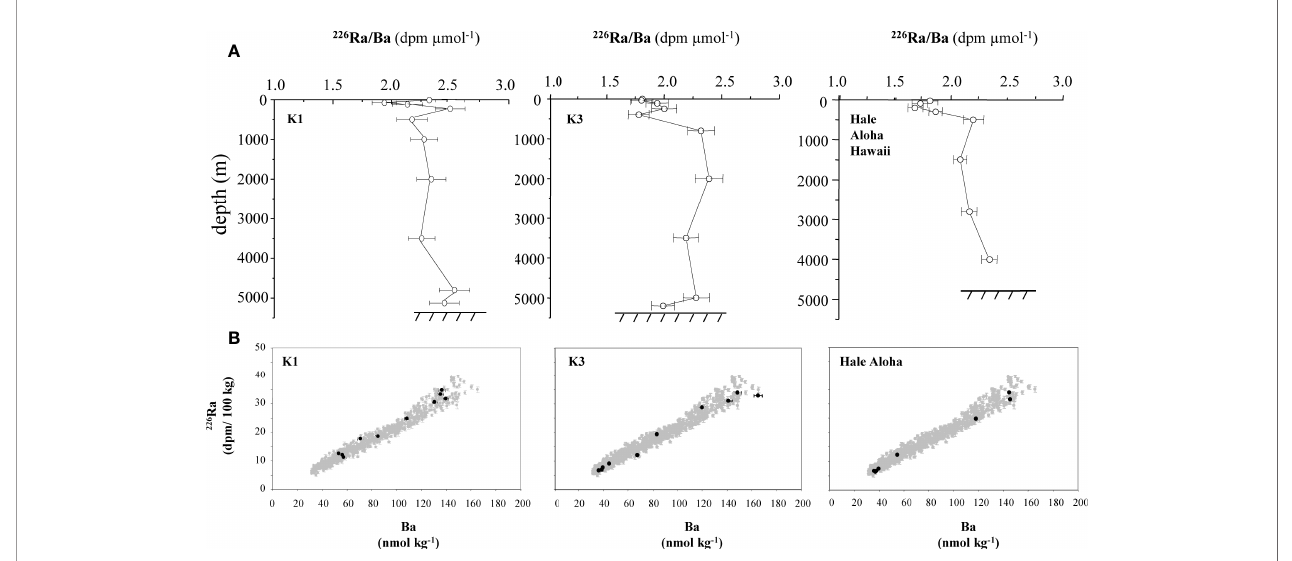
FIGURE 4 | Vertical pro fi les of 226 Ra/Ba ratios in seawater at the three investigated sites: stations K1 and K3 in the North West Paci fi c; old station Hale Aloha, off Hawaii (A) . The relationship between Ba and 226 Ra found at these stations (solid circles) is also compared to the Ba- 226 Ra relationship reported from the GEOSECS program (B) .